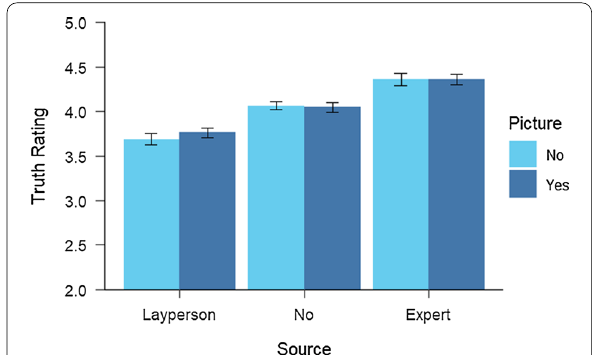
Fig. 1 Mean truth ratings in Experiment 1 as a function of source and picture conditions. Error bars represent standard error of the